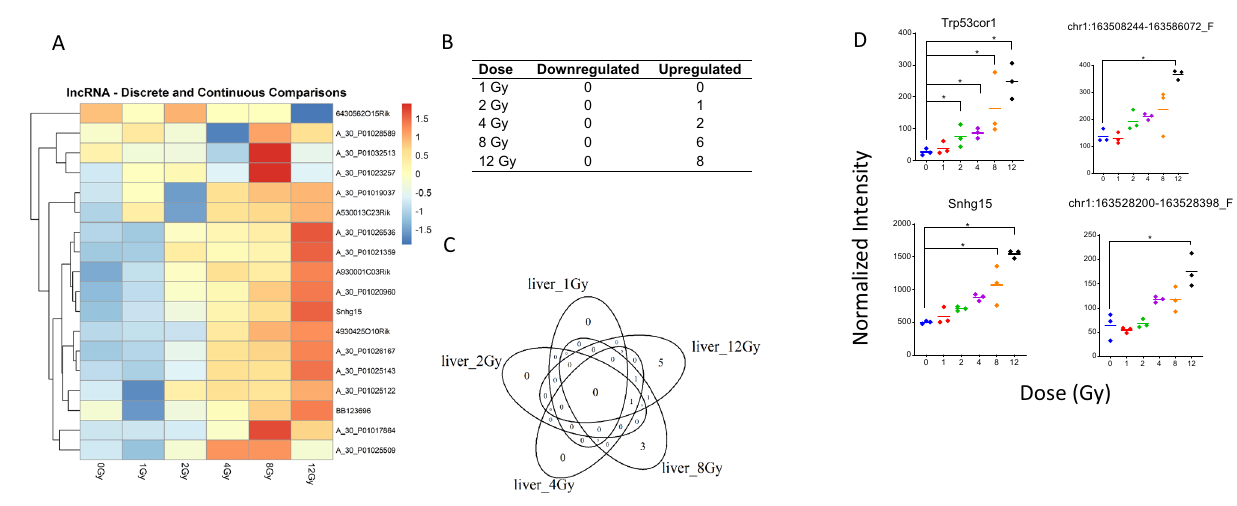
Figure 5. Radiation-induced long non-coding RNA expression profiles in mouse liver tissue. ( A ) Heatmap displays expression patterns, of all differentially expressed lncRNAs across all doses and controls. A linear model was fit to each lncRNA probe to assess differential expression of irradiated compared to control samples using criteria of |log2FC|> 1 and B-H p value < 0.05. ( B ) The table shows the number of discrete down- versus up-regulated lncRNAs at each dose. ( C ) Venn diagram shows dose distribution and overlap of differentially expressed lncRNAs across all doses. ( D ) Examples of significant linearly up- and down-regulated lncRNAs are shown to display the dose response of lncRNAs to radiation in liver tissue samples. Asterisk (*) indicates statistical